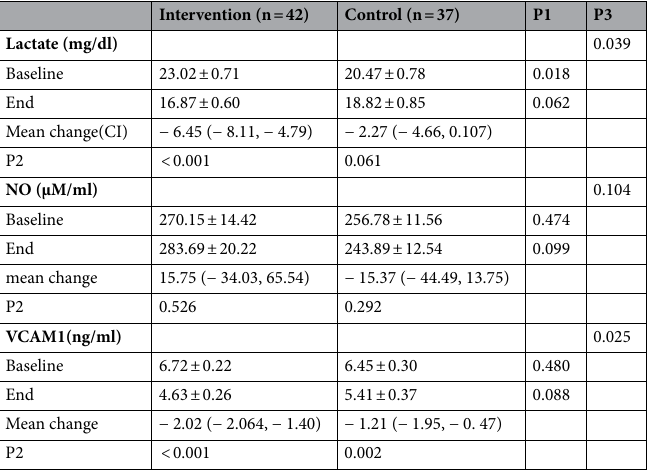
Table 4. The effects of Alpha-lipoic acid supplementation on mitochondrial metabolic disorders marker, and vascular markers. P1 resulted from independent t-test, P2 resulted from paired sample t-test, P3 resulted from analysis of covariance in the adjusted models (adjusted for baseline level of each Variable, age, BMI, Marital status, Education status, Economic status, Drugs, Physical activity and energy intake); All values are means ± SE.